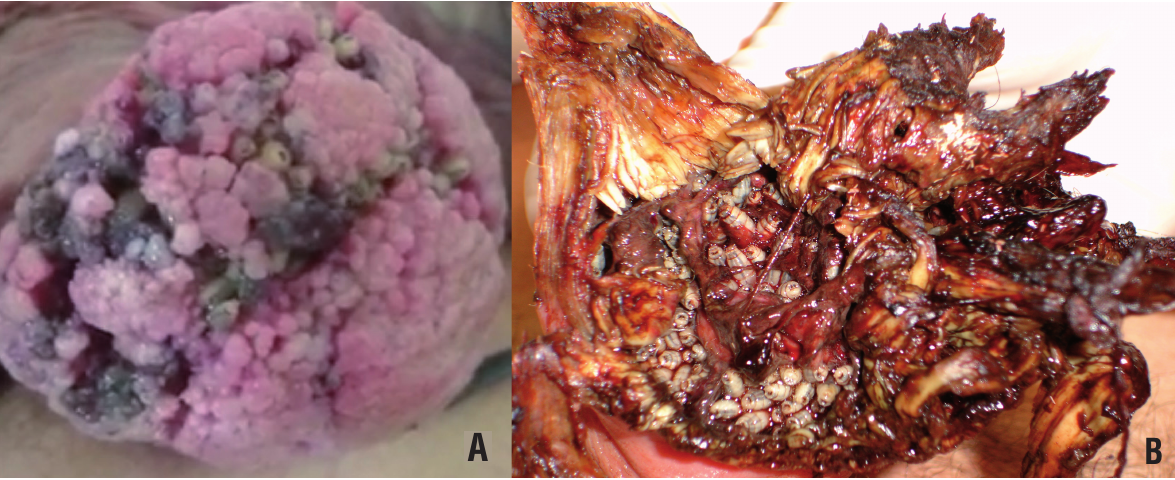
(Added with permission of Int Braz J